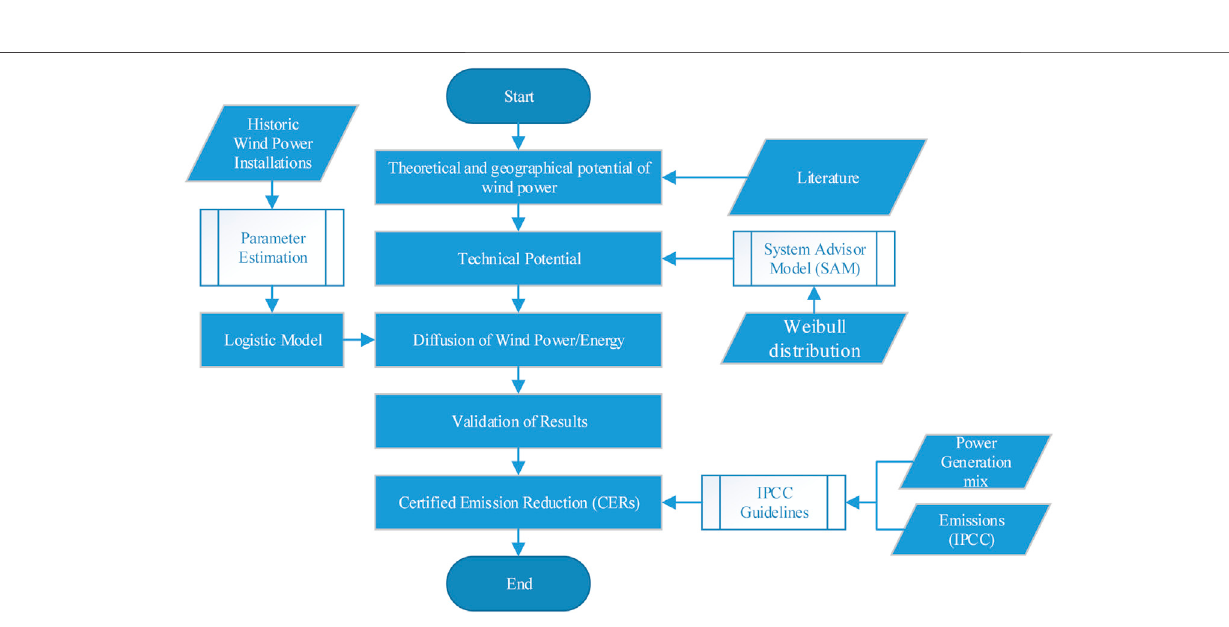
FIGURE 5 | Methodological work fl ow.